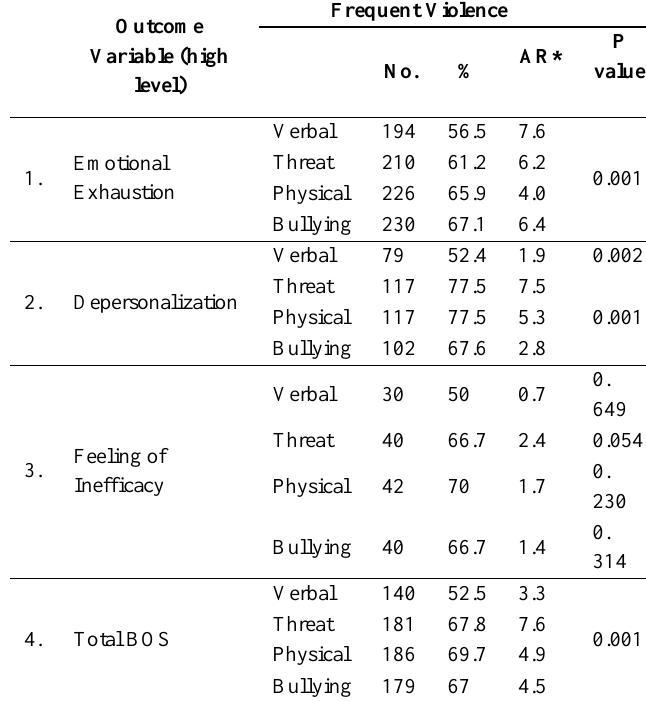
Table 4: Distribution and significant association of violence types and high level of the outcome variables: